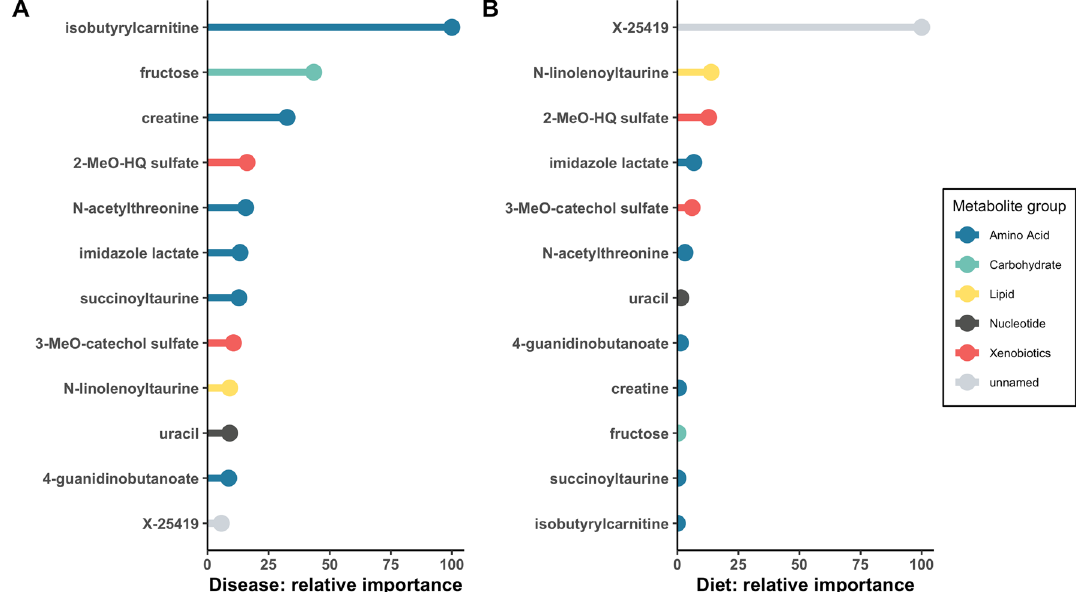
Figure 1. Random forest machine learning analysis was used to evaluate the 12 metabolites that overlapped between disease and diet comparisons at baseline in 75 dogs for their relative contribution in the biochemical importance plot. The super pathway for each metabolite is indicated by color as defined by the legend on the right. ( A ) Comparison based on disease (DCM vs. healthy controls). These metabolites had a predictive accuracy of 86%, ( B ) Comparison based on diet. These metabolites had a predictive accuracy of 87%. Key: 2-MeO-HQ sulfate, 2-methoxyhydroquinone sulfate (1); 3-MeO-catechol sulfate, 3-methoxycatechol sulfate